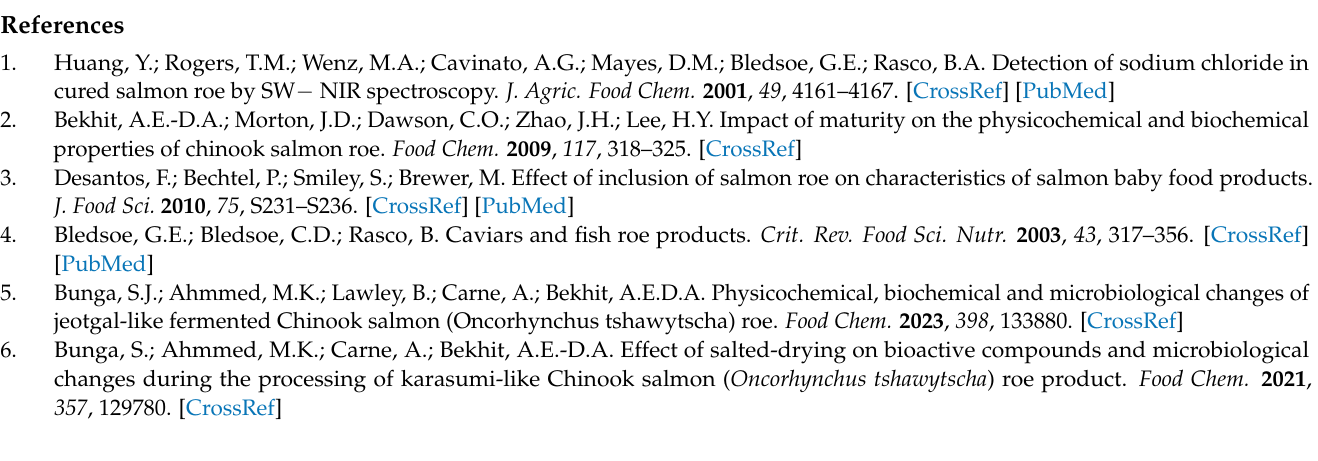
Figure S4: Expansions of 13C NMR spectra of lipids extracted from fresh, salted, and fermented salmon roe in the methyl end region; Table S1: The regions and assignments of 13C NMR that can be noticed from the spectra of salmon roe